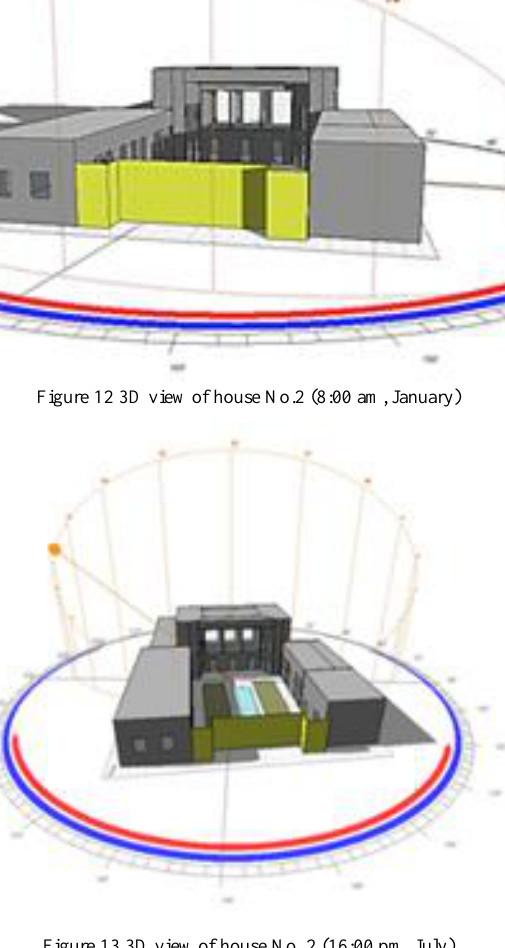
Figure 13 3D view of house No. 2 (16:00 pm,